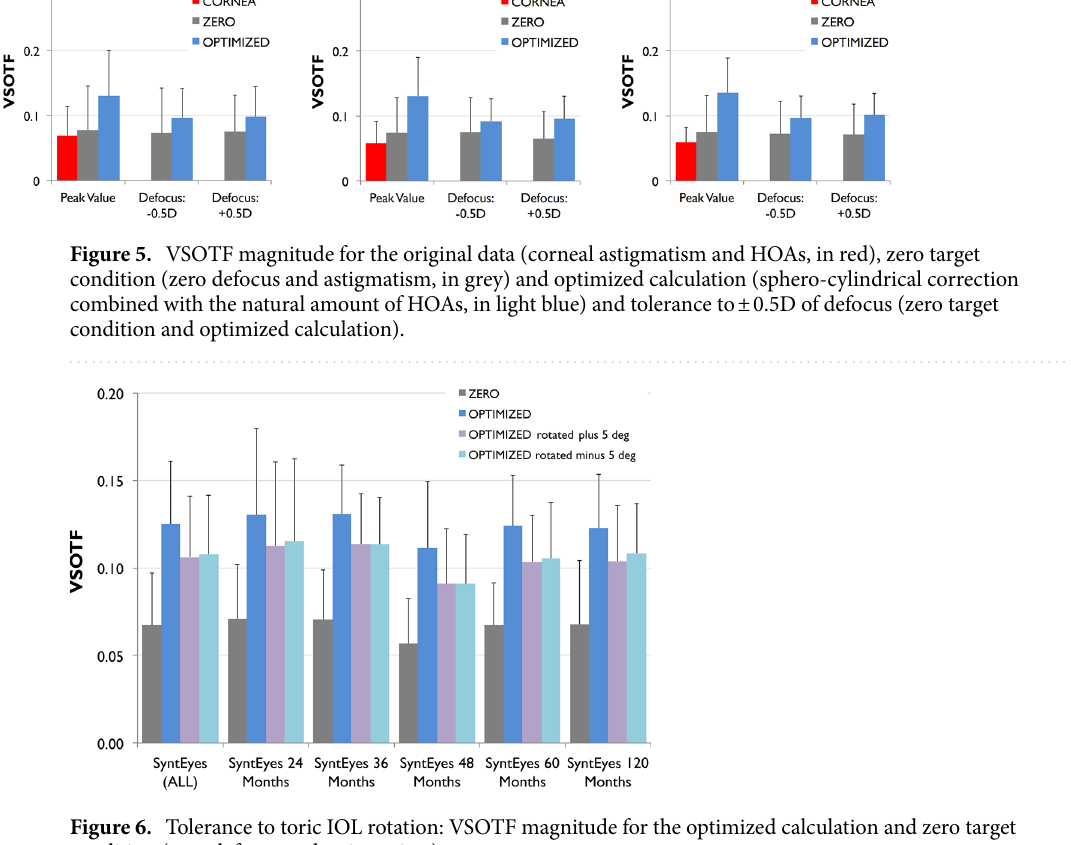
Figure 6. Tolerance to toric IOL rotation: VSOTF magnitude for the optimized calculation and zero target condition (zero defocus and